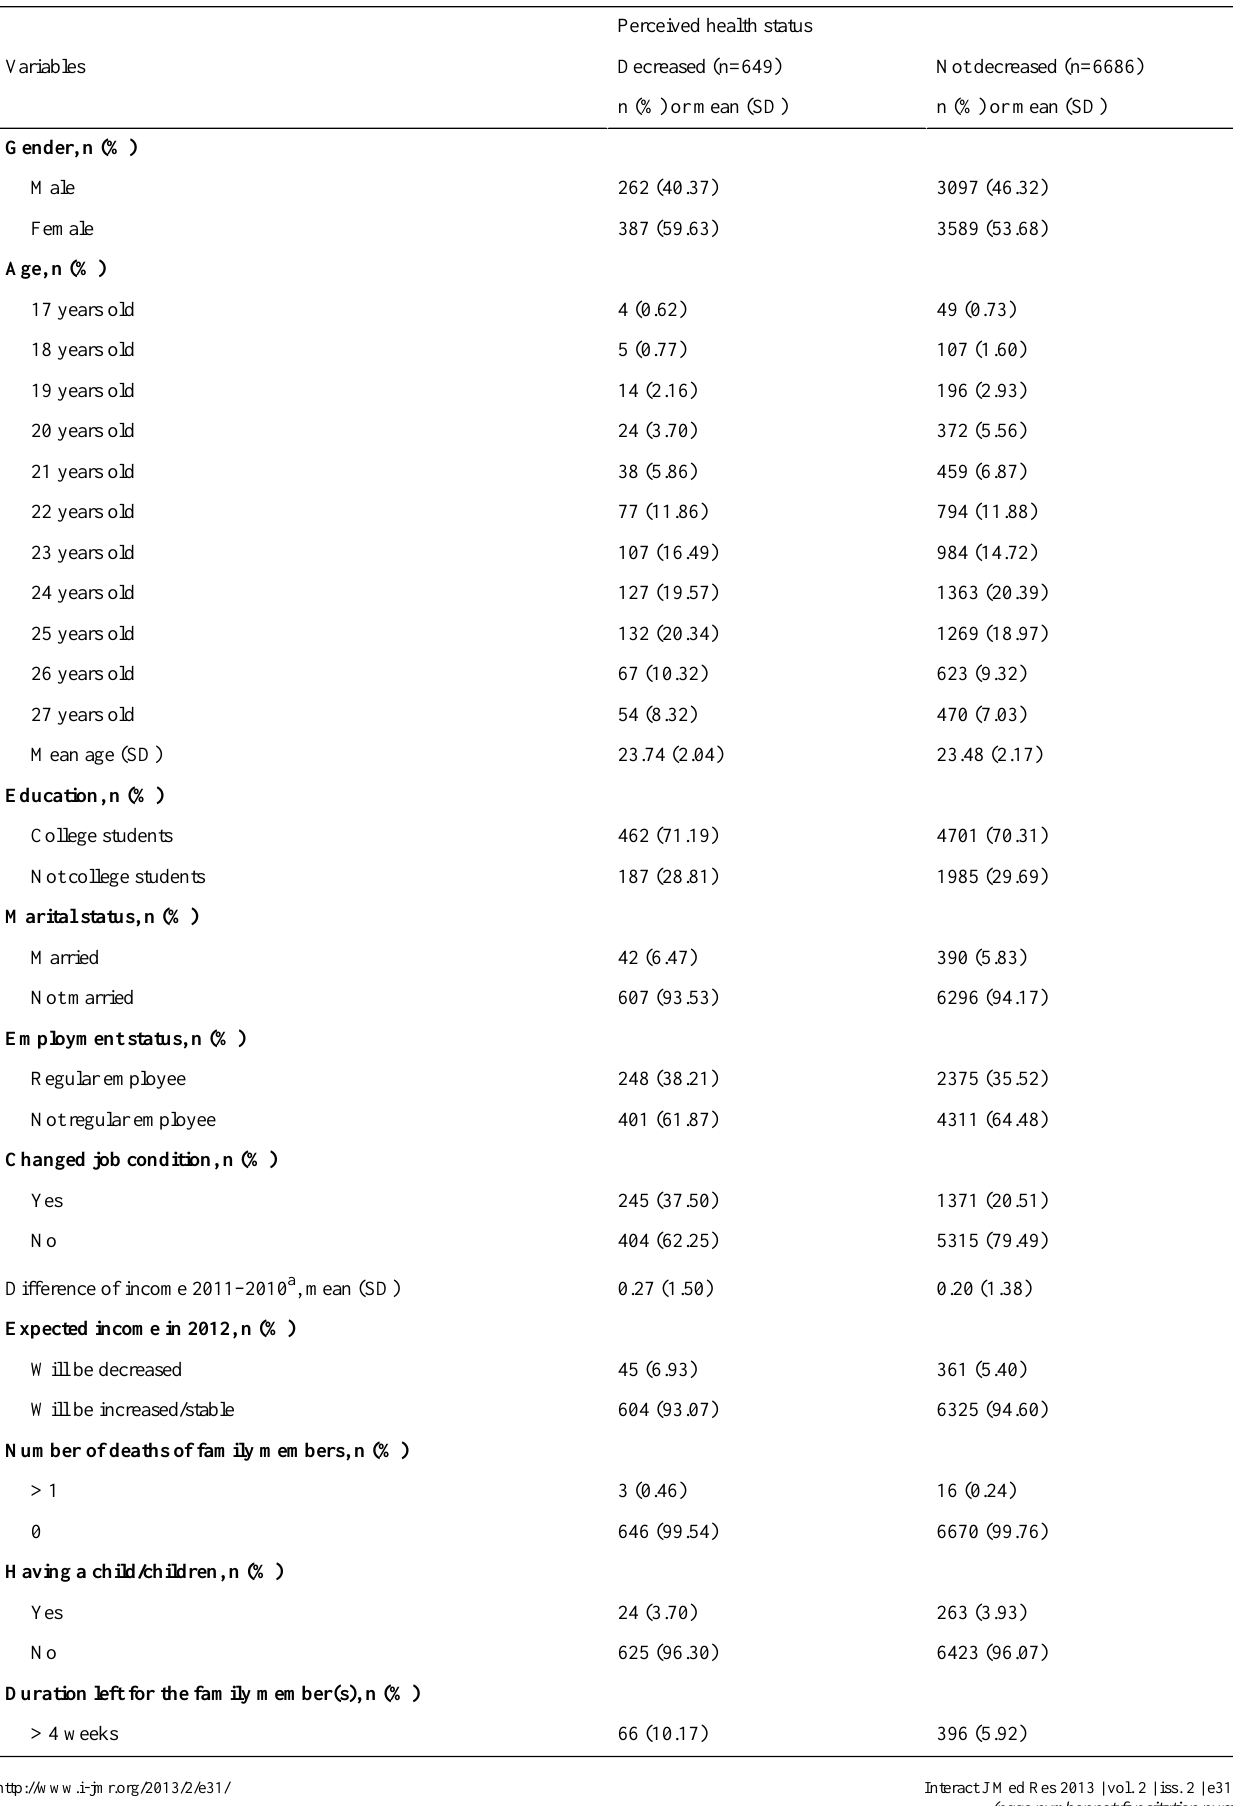
Table 1. Demographic characteristics by the change of subjective